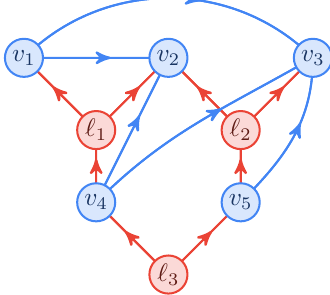
Figure 2: The causal structure G 2 in this figure encodes a causal hypothesis about the causal relationships between the visible variables V = { v 1 , v 2 , v 3 , v 4 , v 5 } and the latent variables L = { ℓ 1 , ℓ 2 , ℓ 3 } ; e.g. v 2 experiences a direct causal influence from ( v 2 ) = { ℓ 1 , ℓ 2 } . Throughout this paper, visible variables ( v 2 ) = { v 1 , v 4 } and latent lpa each of its parents, both visible vpa G G 2 2 and edges connecting them are colored blue whereas all latent variables and all other edges are colored